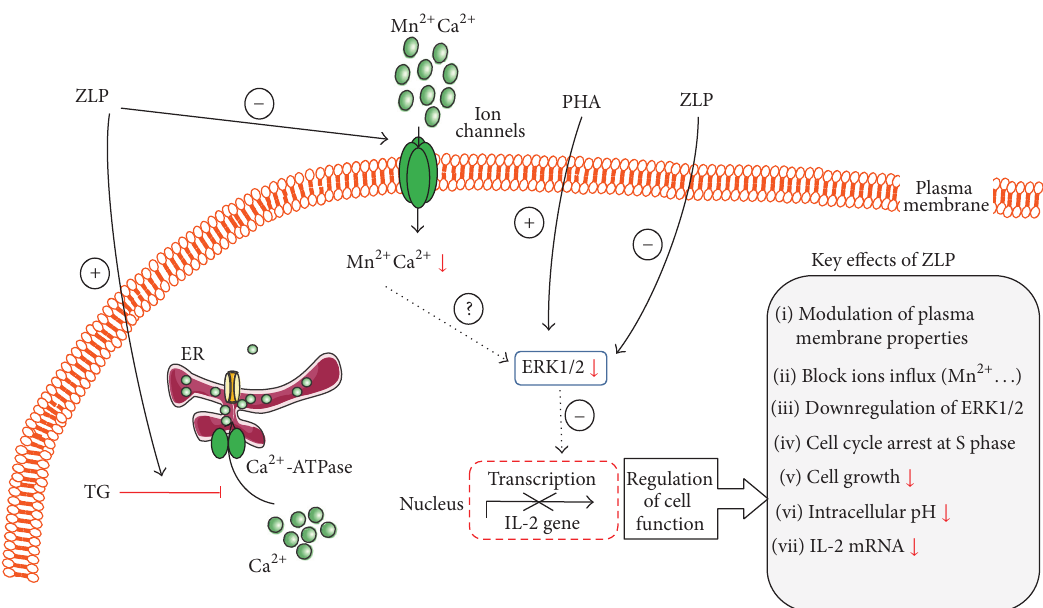
Figure 3: Schematic representation of Z. Lotus phenolic compounds-induced immune cell signaling. Note: ZLP: Z. Lotus polyphenols; TG: Thapsigargin; PHA: phytohemagglutinin (see text for